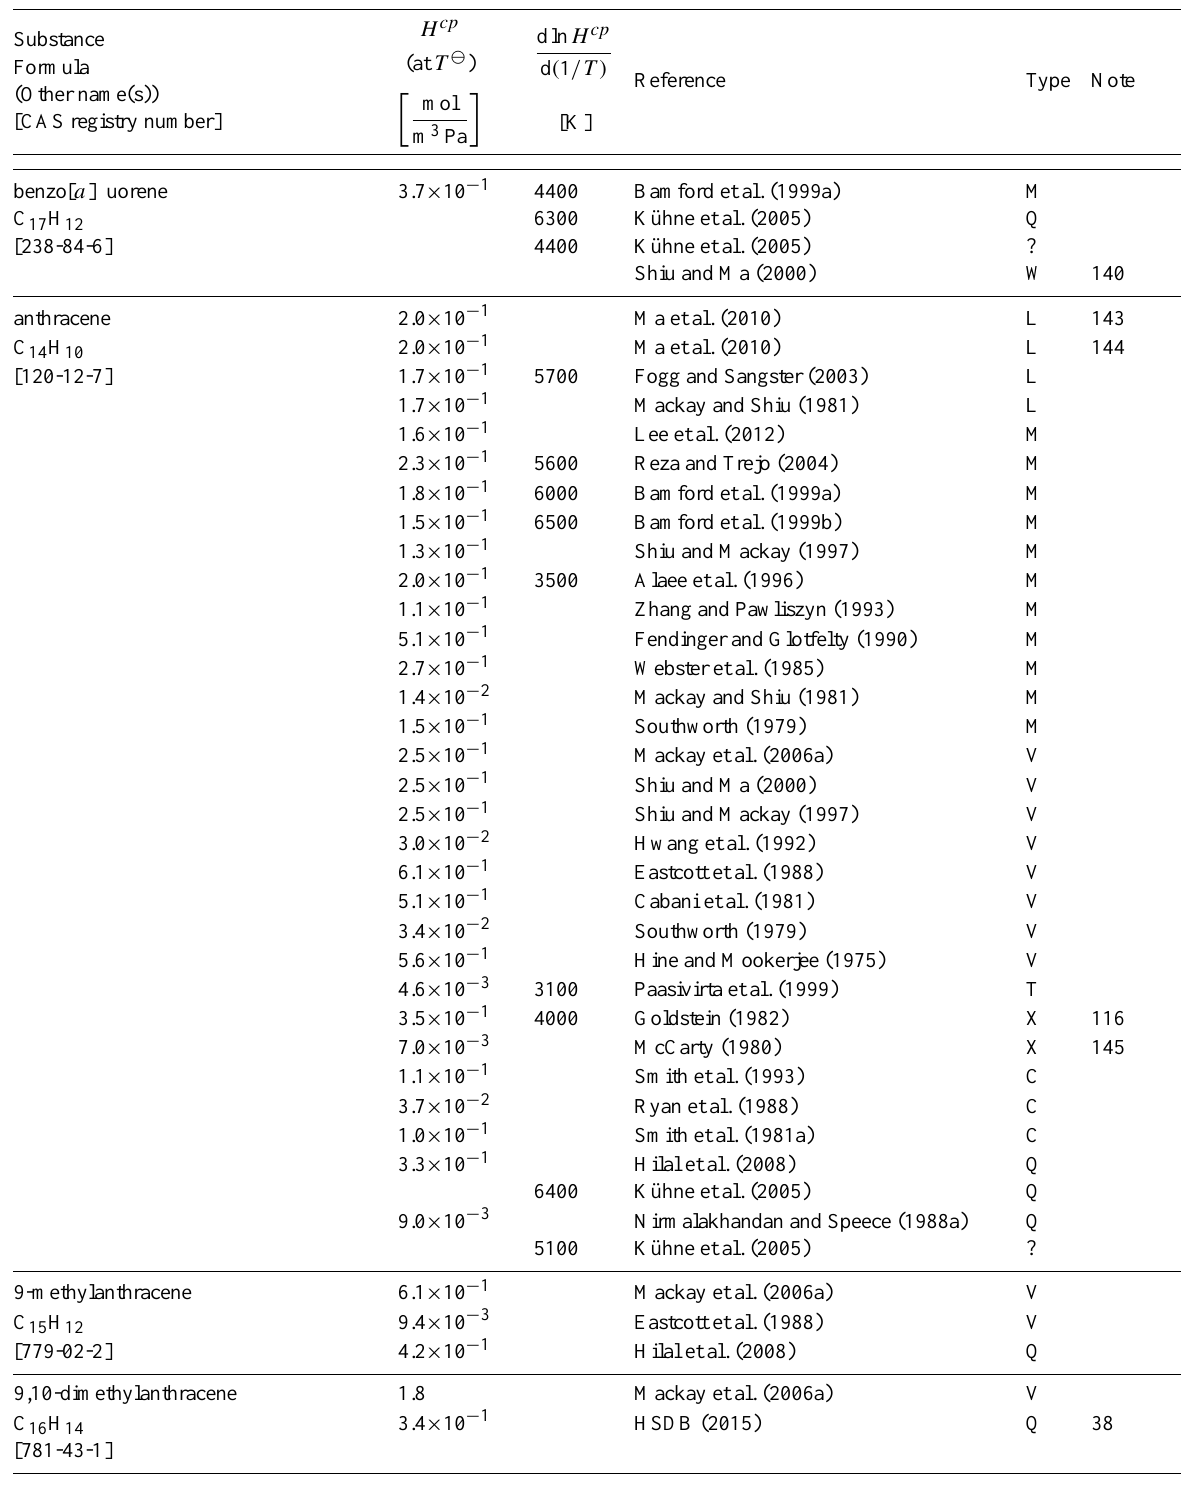
Table 6: Henry’s law constants for water as solvent